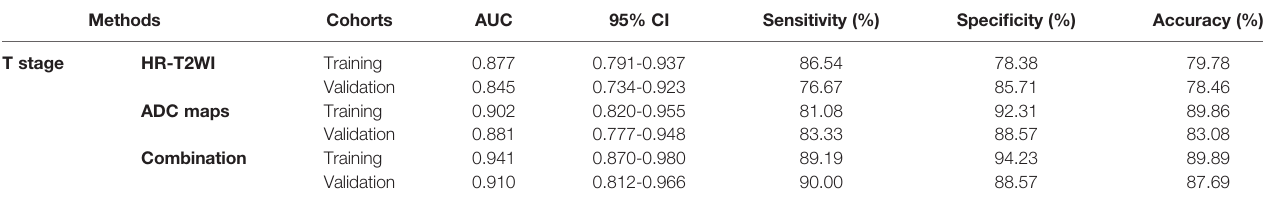
TABLE 4 | Performance of classi fi cation models for identifying preoperative T stage of rectal cancer. Methods